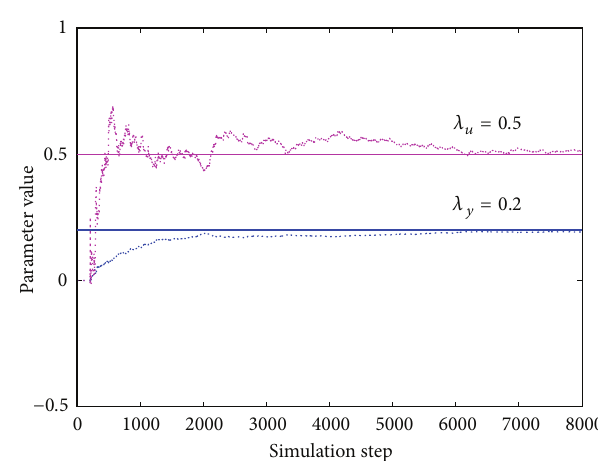
Figure 3: Estimation result of 𝜆 𝑦 and 𝜆 𝑢 in System 1.